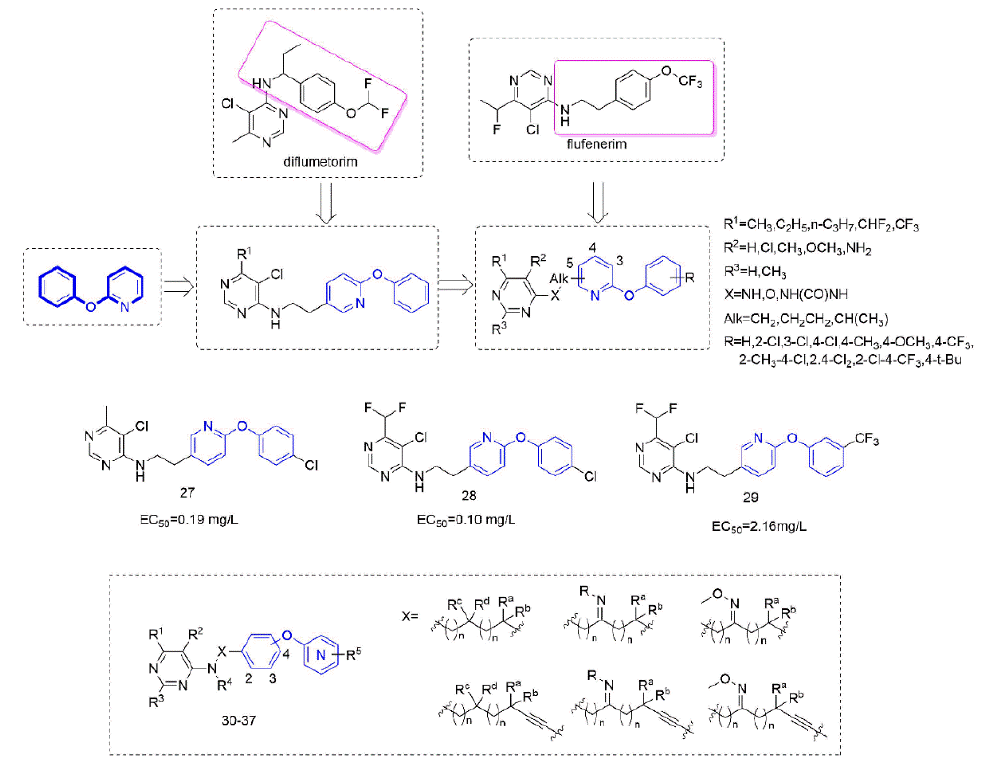
Figure 6. Complex I inhibitors containing phenoxypyridine.